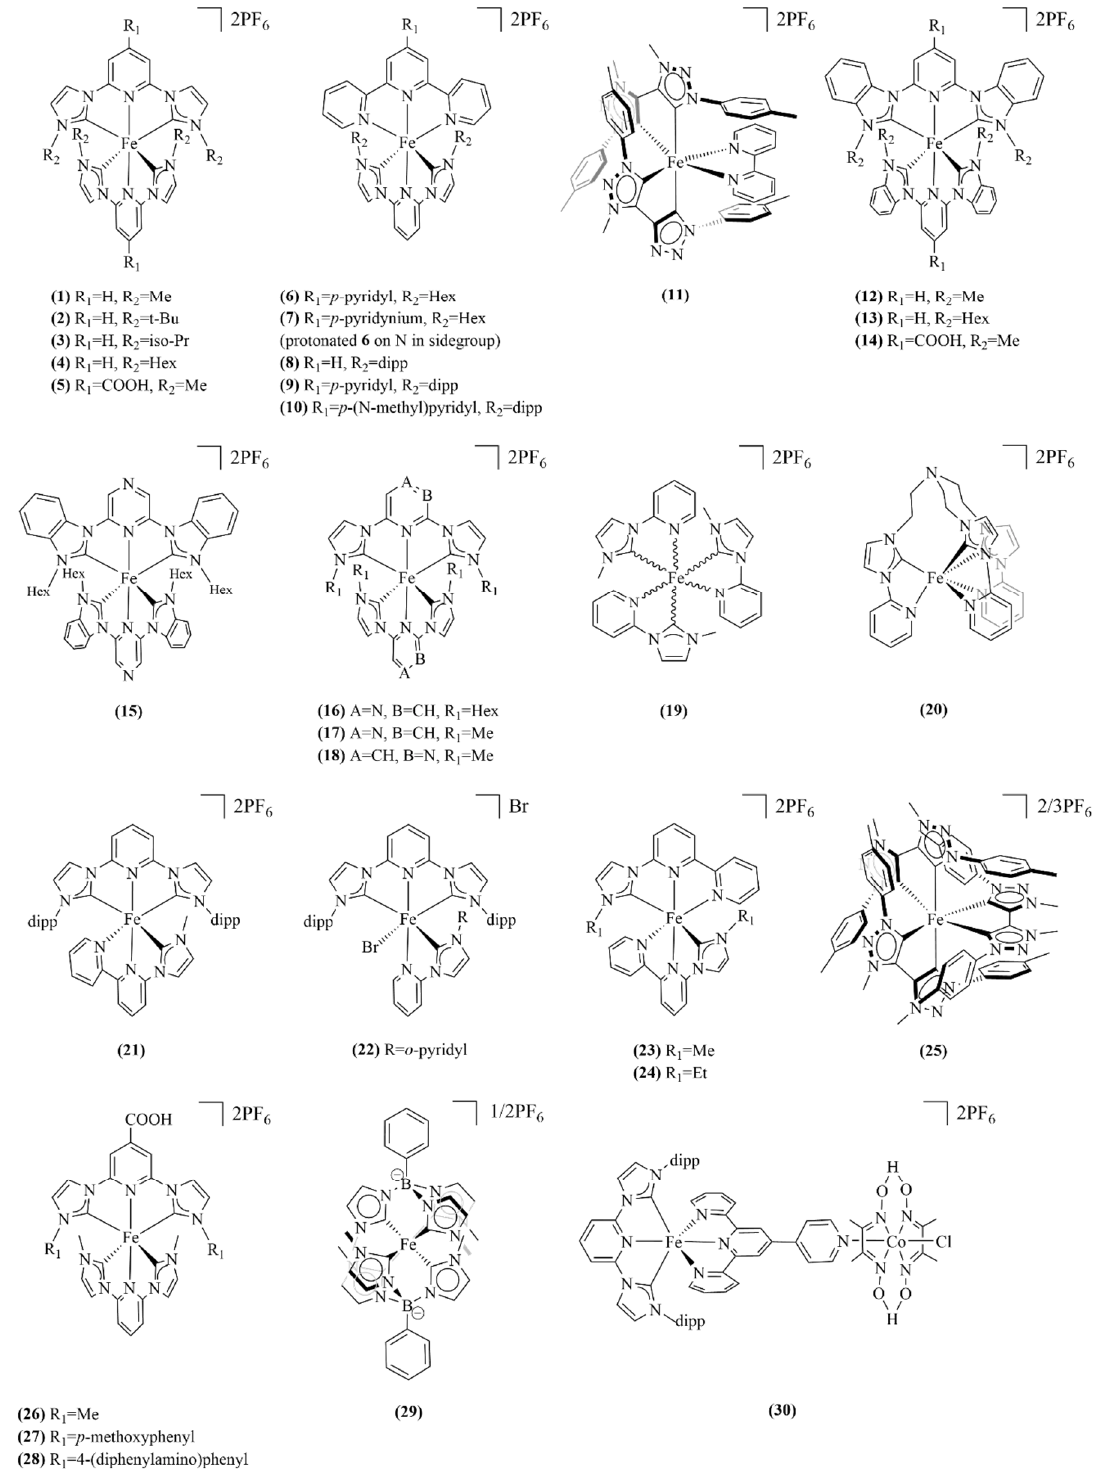
Figure 4. Chemical structures of photofunctional FeNHC complexes discussed in the text; dipp=diisopropylphenyl.